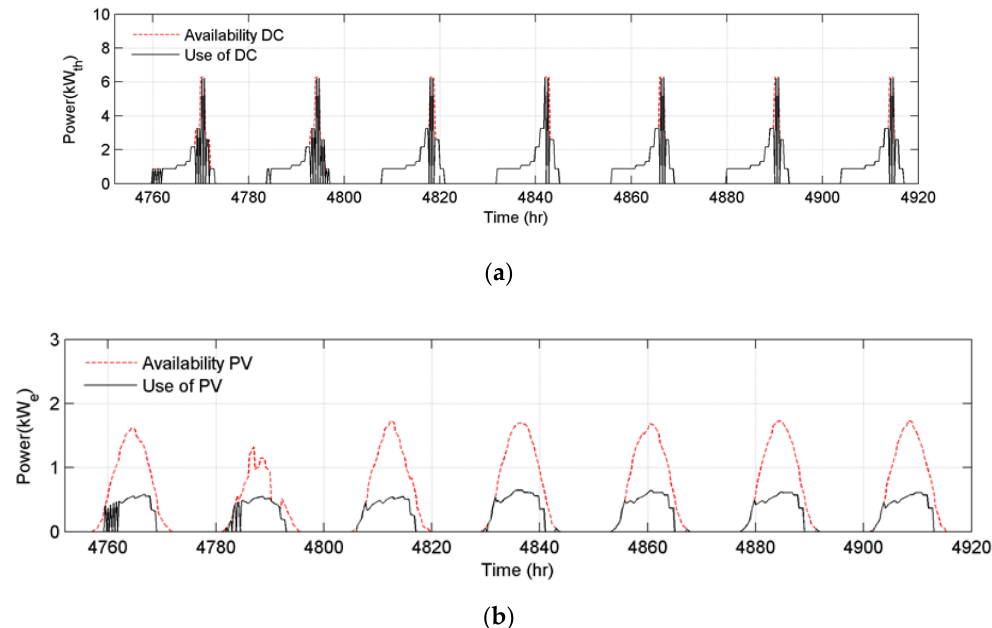
Figure 9. Energy sources used to cover the weekly cooling demand of the building compared to the availability profiles with RBC: ( a ) DC; ( b ) PV.